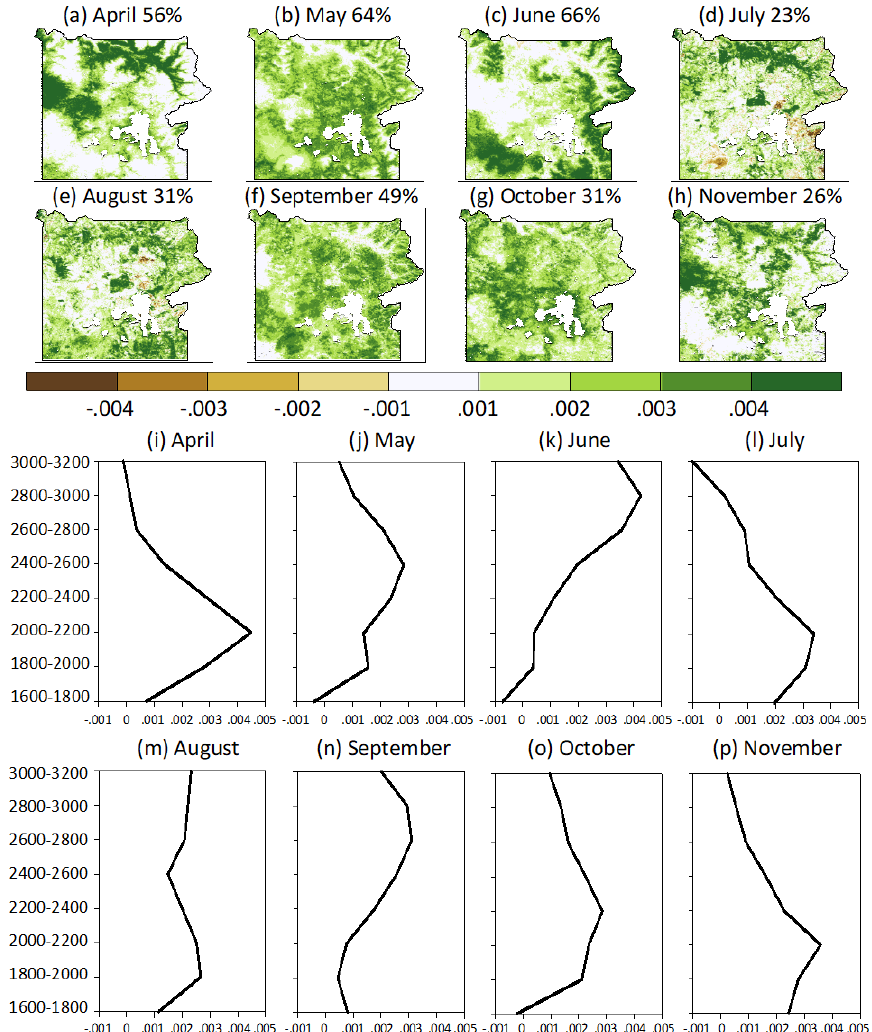
Figure 6. ( a – h ) Maps of the leading mode (EOF1) of Moderate Resolution Imaging Spectroradiometer (MODIS) detrended Normalized Difference Vegetation Index (NDVI) variability for April–November from 2000–2017 based on empirical orthogonal function (EOF) analysis for Yellowstone National Park. The percent explained variance in NDVI anomalies is provided by each map. ( i – p ) Average EOF1 loading pattern by elevation (in 200-m bins), with green shading indicating the preferred elevation for specific patterns of variability shown in ( a – h ).